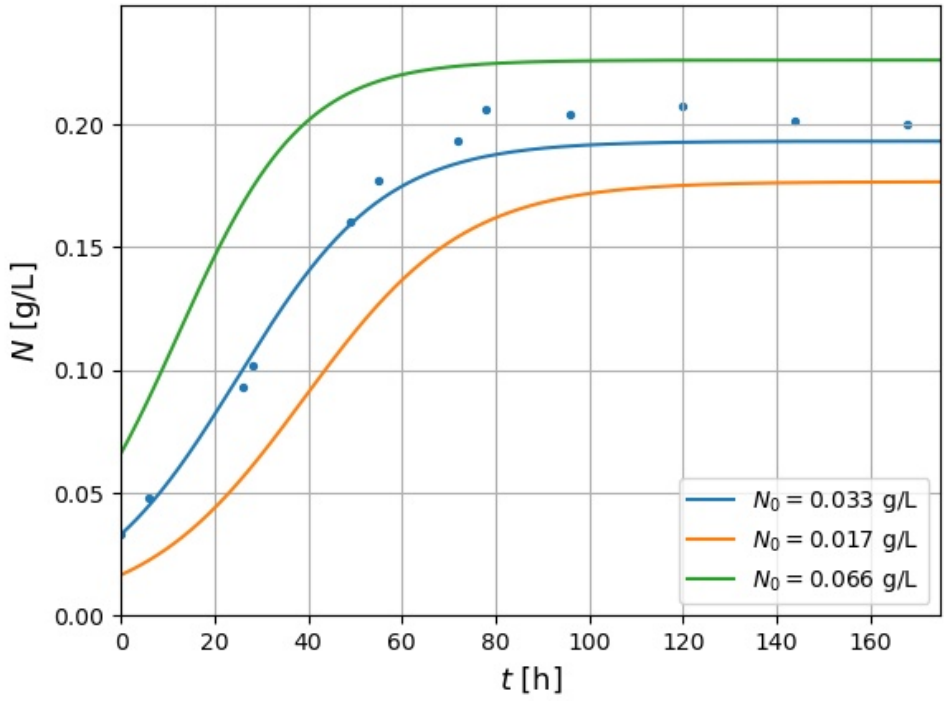
Figure 3. Dependence of bacteria concentration N ( t ) on various concentrations of the inoculate. All independent parameters ( a = 60 g/L, r m = 4 h − 1 , γ = 0.2, and S o = 0.8 g/L) were kept constant. Blue dots correspond to the experimental data.